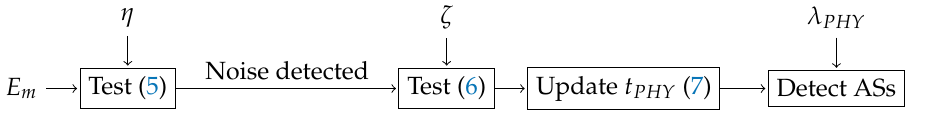
Figure 2. Block diagram for the defense mechanism against the SSDF attack. The inputs are the energy levels reported by the sensors E m , the defense mechanism parameters are η , ζ and λ PHY , and the result is an updated list of sensors detected as